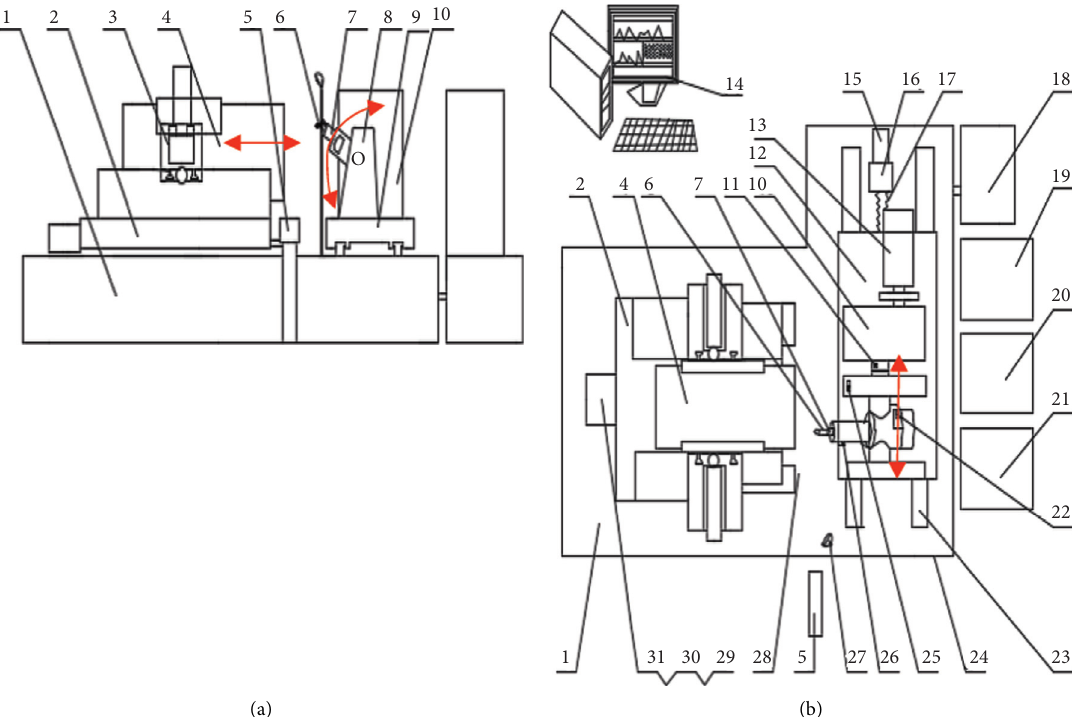
Figure 1: Schematic drawing of single pick cutting rock test equipment. (a) Front view. (b) Vertical view. 1: base fixture; 2: stone moving device; 3: stone clamping device; 4: stone; 5: test control system; 6: test pick; 7: cutting force sensor; 8: cutting driving device; 9: tool holder